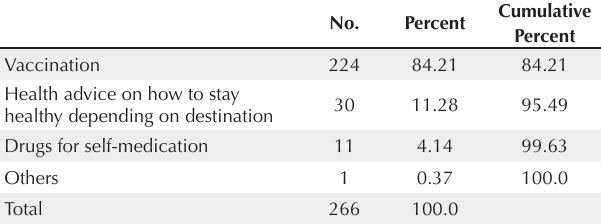
Table 4. Importance of Pre-travel Services as Perceived by Respondents